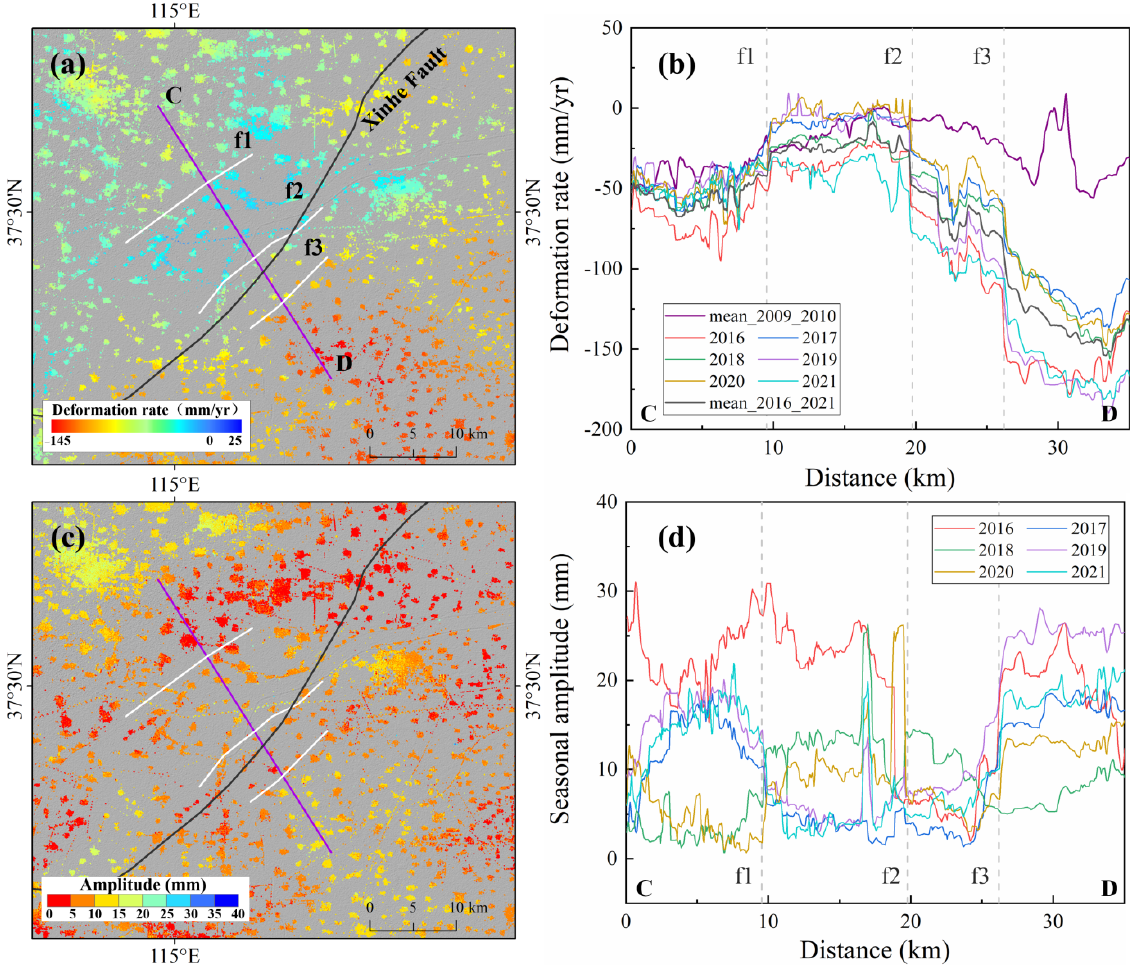
Figure 11. ( a ) The map of InSAR-derived land deformation rate during 2015~2021 in Zone B. ( b ) Profile of deformation rate along line of CD during 2009~2010 and 2016–2021. ( c ) The map of amplitude of seasonal deformation in 2020 in Zone B. ( d ) Profile of amplitude of seasonal deformation along line of CD during 2016–2021. The purple line marks the profile line, the white lines represent the potential fissures and the black line marks the fault.